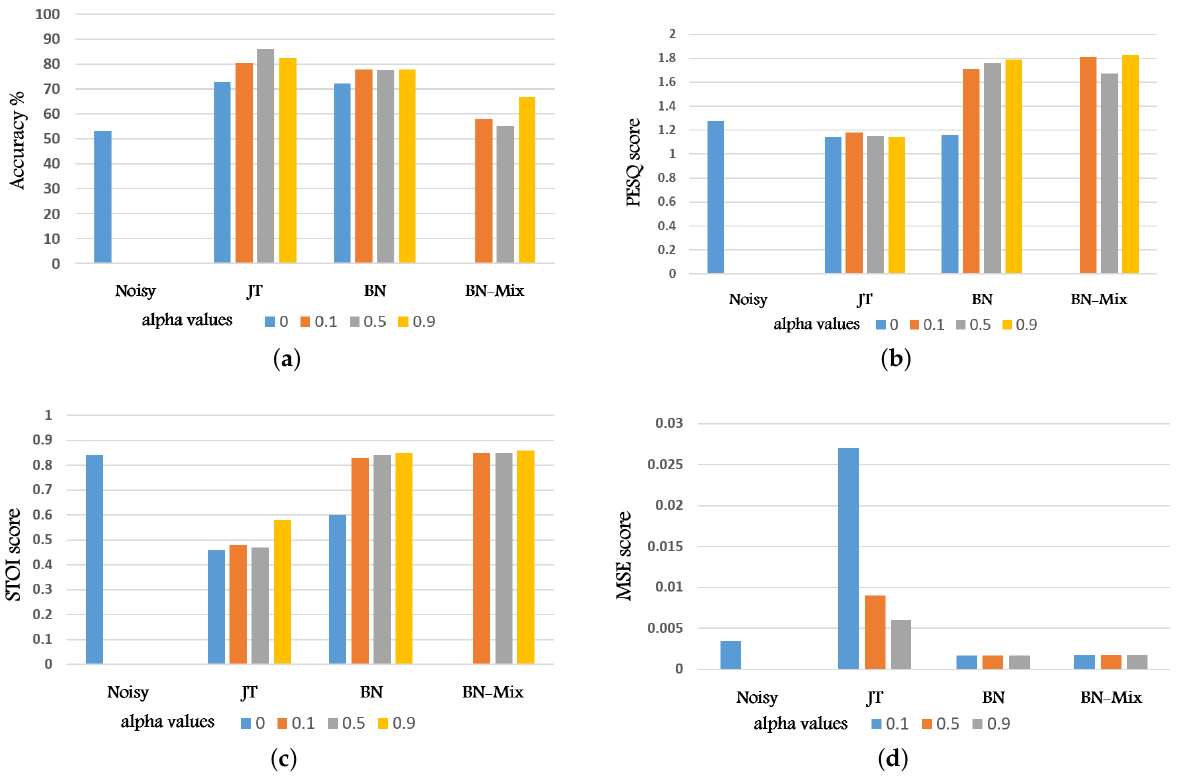
Figure 6. Graphical representation for: ( a ) the classification accuracy. ( b ) PESQ metric. ( c ) STOI metric. ( d ) MSE metric against α values for all